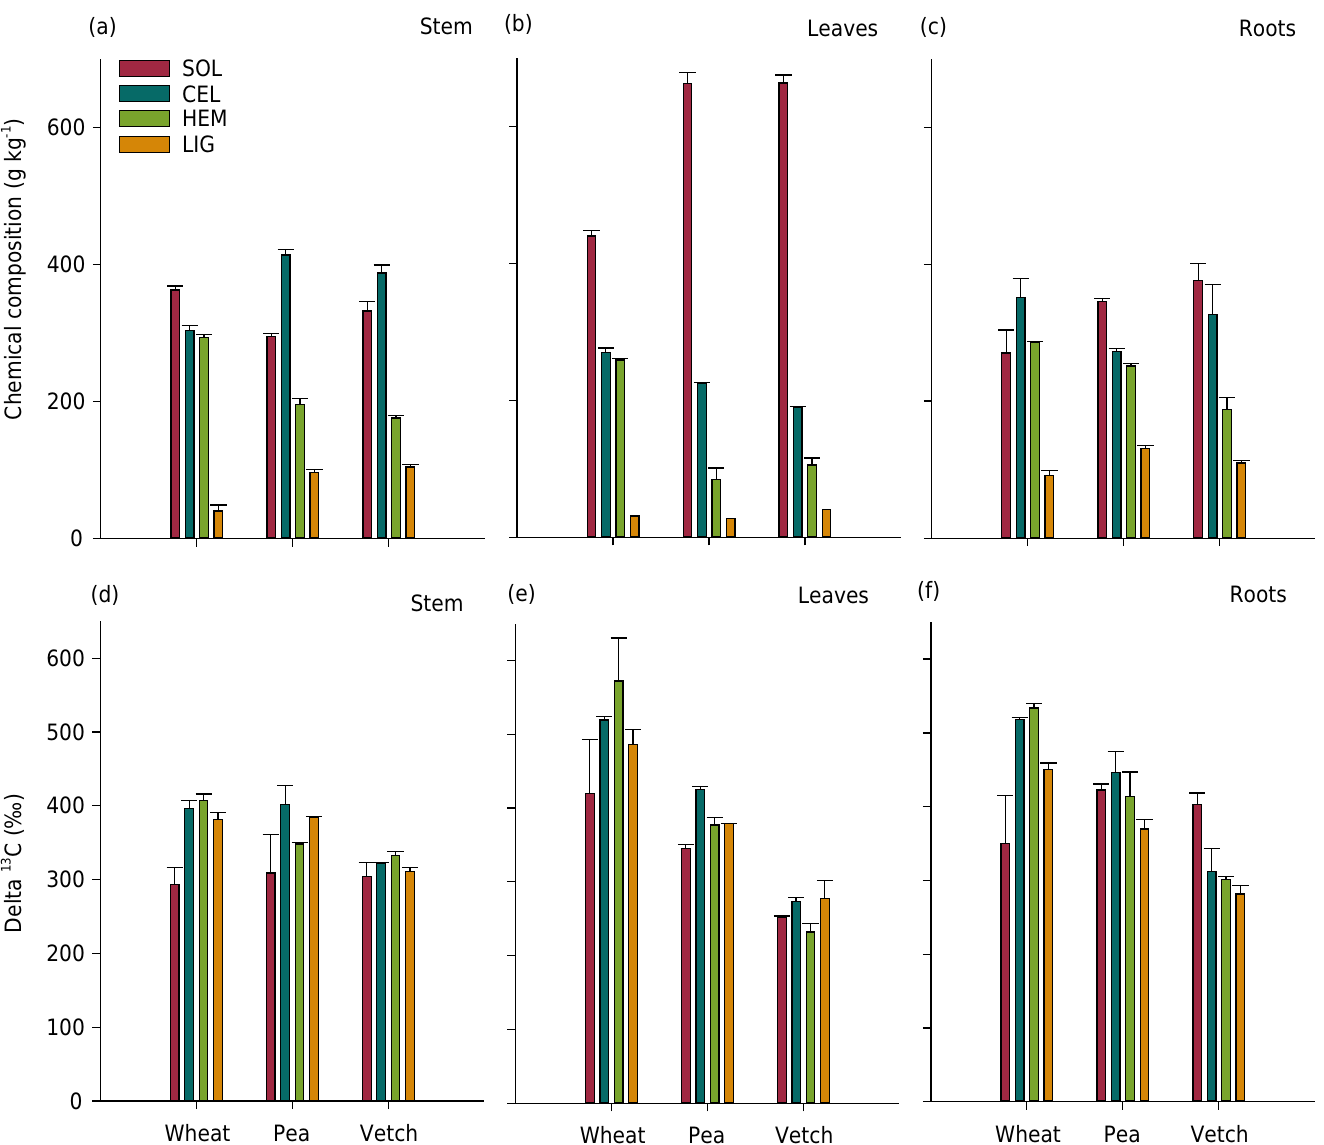
Figure 2. Chemical composition (a, b, and c) and δ 13 C of chemical fractions (d, e, and f) in the stems, leaves, and roots of three crops grown under field conditions. Error bars indicate the standard error ( n = 3). SOL: soluble fraction; CEL: cellulose; HEM: hemicellulose; LIG: